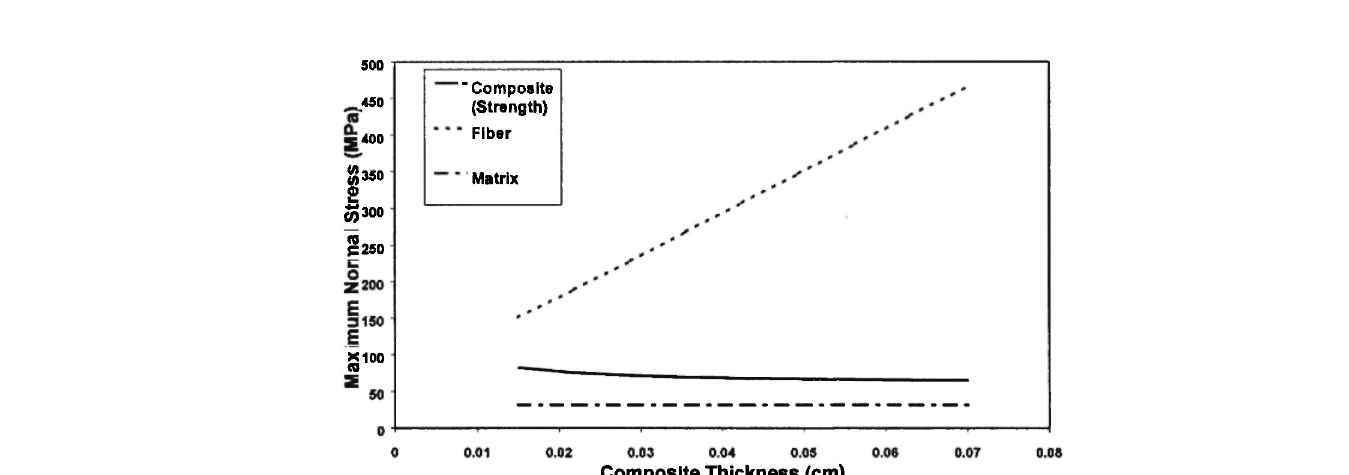
Fig. 8(a): Maximum normal stress in composite, fiber, and matrix vs the thickness of the composite,which is loaded in wale direction.The geometric parameters used are: αΗ).0445cm, Z),,=177.8(Tex), Ä>=0.45, pj= 2.54g/cm\ C=2.5loop/cm, and W= 2 loop/cm.